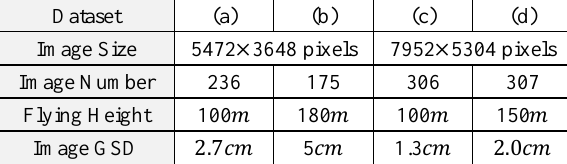
Table 2. characteristics of